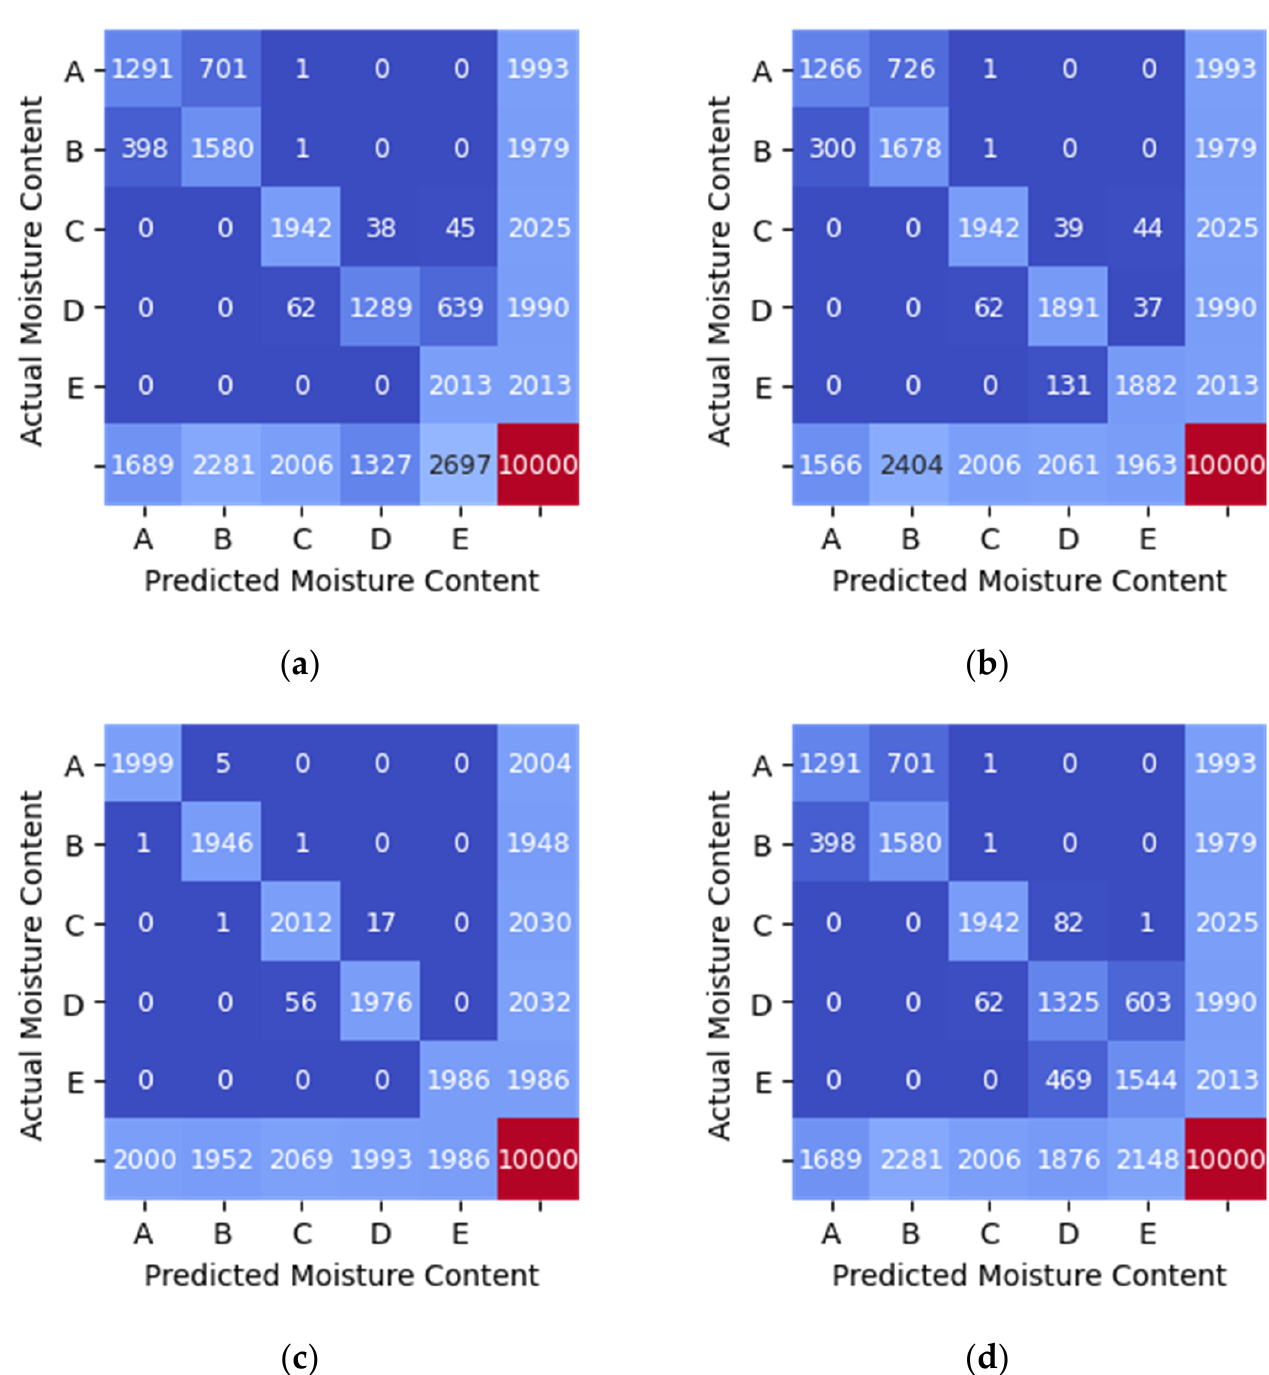
Figure 8. Confusion Matrix Heatmap of RSSI_WSN data. ( a ) SVM (linear kernel). ( b ) Random For- est. ( c ) KNN ( n = 5). ( d )